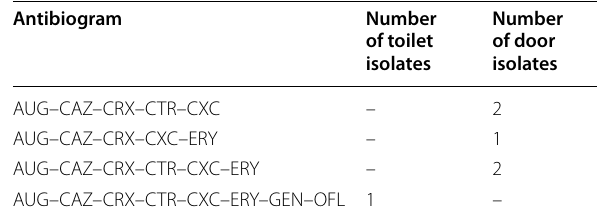
Table 2 Drug resistance pattern of vancomycin-resistant isolates